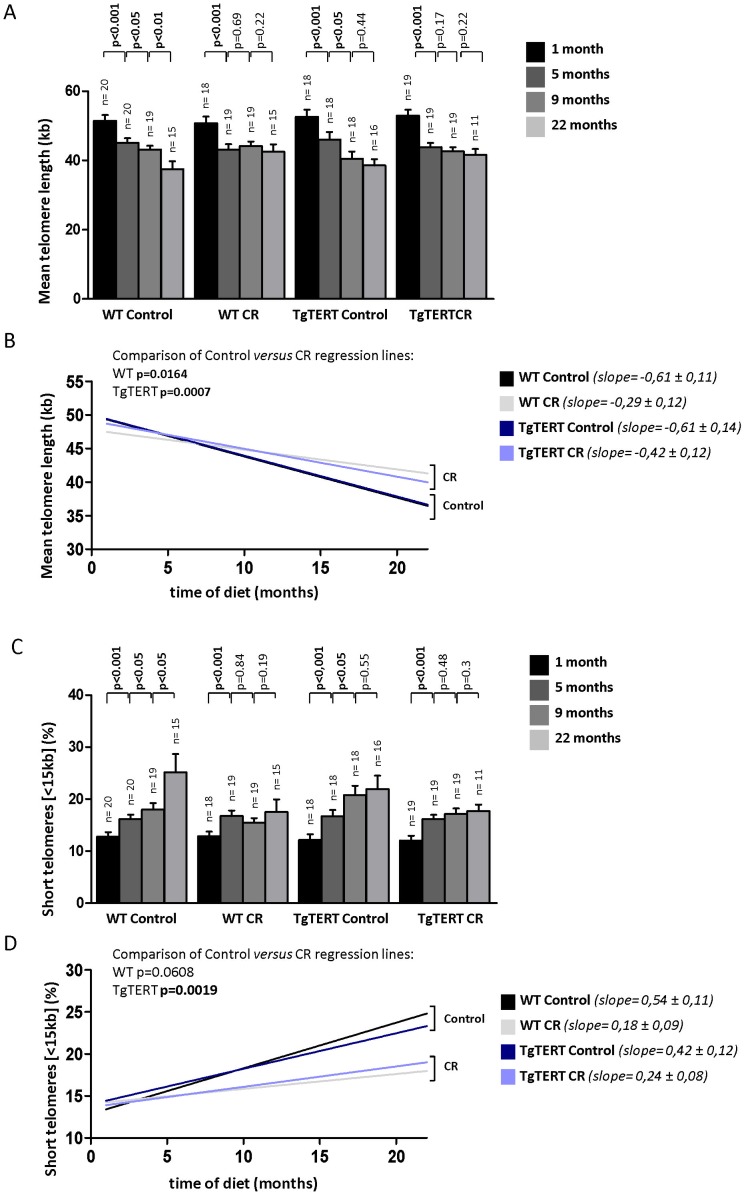
Slower age-dependent telomere shortening in mice under calorie restriction.(A and C) Mean telomere length (A) and percentage of short telomeres (C) was determined by HT QFISH on white blood cells from the indicated mice under CR and control diet. The number of mice is indicated on the top of each bar (n). Values are given as average ± SEM, and statistical significance was determined by one-tailed Student’s t-test. (B and D) Linear regression lines of the values obtained for mean telomere length (B) and percentage of short telomeres (D) measured in white blood cells. The slope ± SD of each regression line is indicated and represents the rate of telomere loss with time.